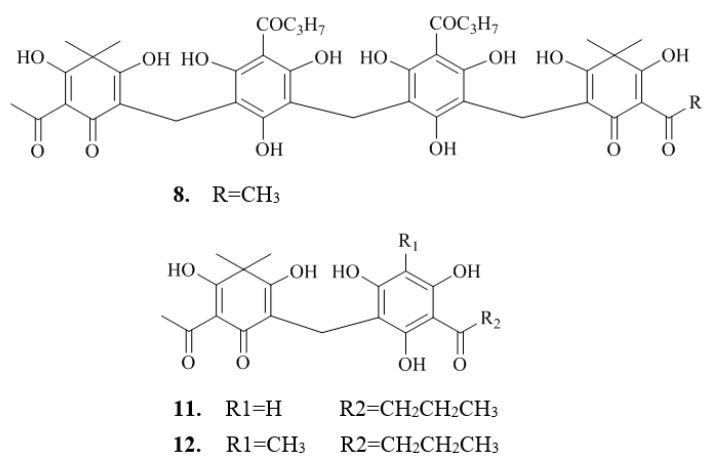
Figure 6. Structures of the 11 known phloroglucinols isolated from Dryopteris crassirhizoma (DC).